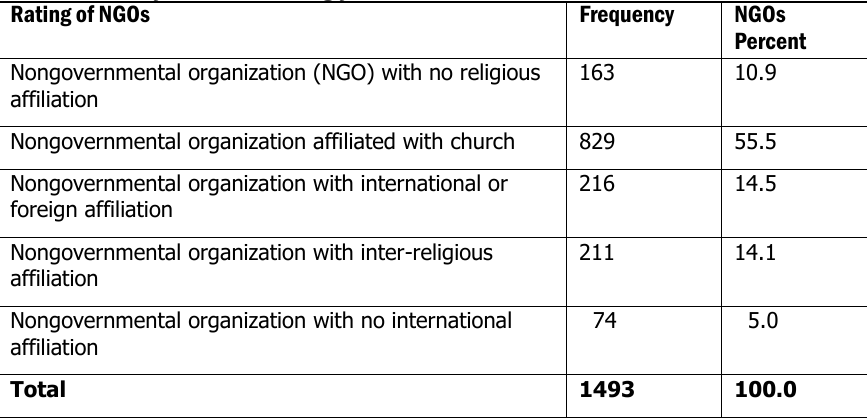
Table 3: Beneficiaries’ Rating from NGO that best meet their Needs Rating of NGOs